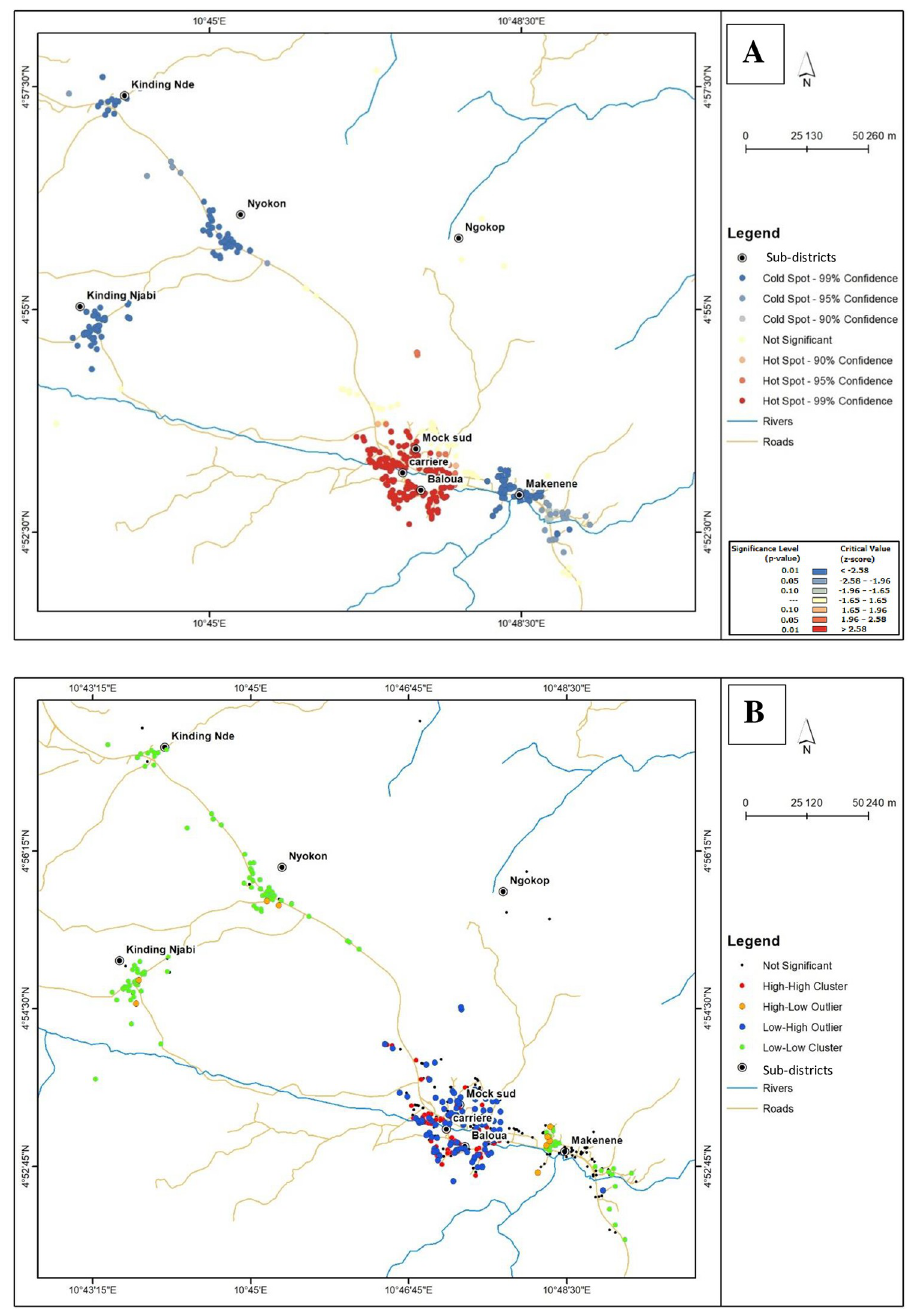
Fig 8. Local Moran’s I cluster maps showing S . mansoni infection intensities inferred from POC-CCA (base layer of the maps were obtained using a free online spatial data software (https://www.diva-gis.org/gdata). High-high cluster indicates significant ( p < 0.05) clustering (hot-spot) of houses of children carrying heavy infection intensities of S . mansoni ; low-low cluster indicates significant ( p < 0.05) clustering (cold spot) of houses of children carrying light infection intensities of S . mansoni ; low-high outlier indicates areas where houses of children carrying heavy infection intensities were surrounded by those of children carrying light or moderate infection intensities; high-low outlier indicates areas where houses of children carrying light infection intensities were surrounded by those of children carrying heavy infection